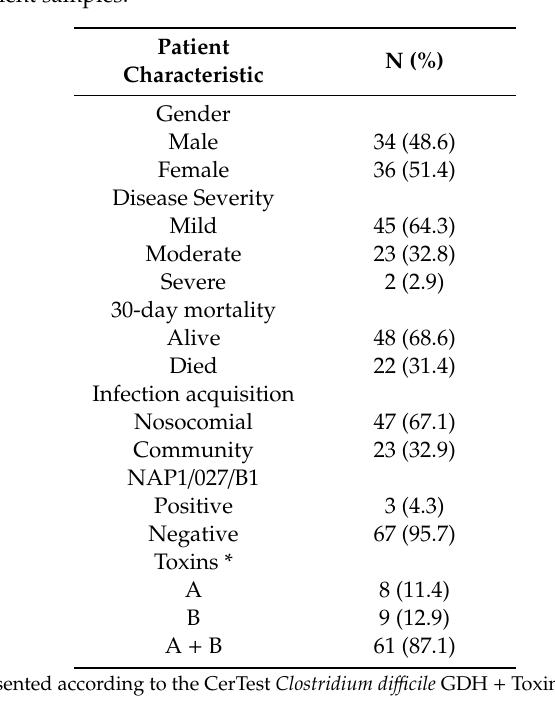
Table 1. Demographic characteristics of patients with Clostridioides di ffi cile infection (CDI) and microbial characteristics of patient samples.